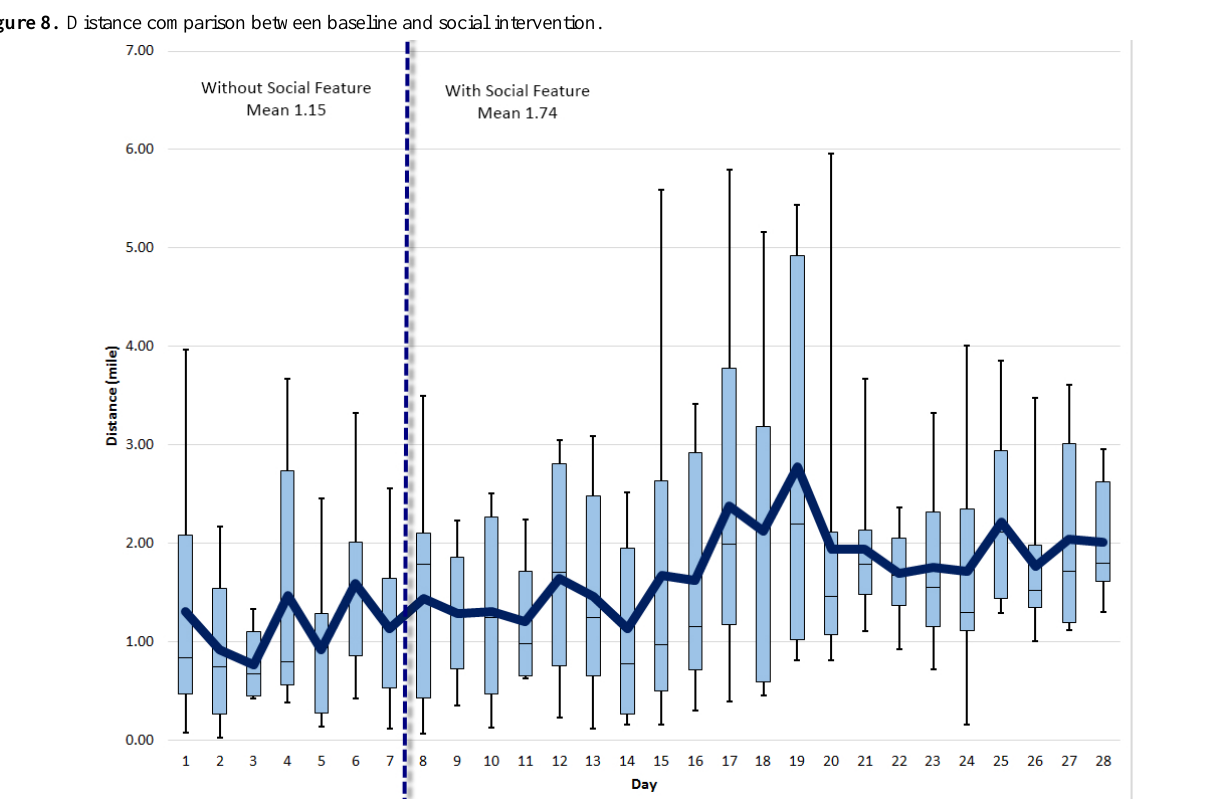
Figure 8. Distance comparison between baseline and social